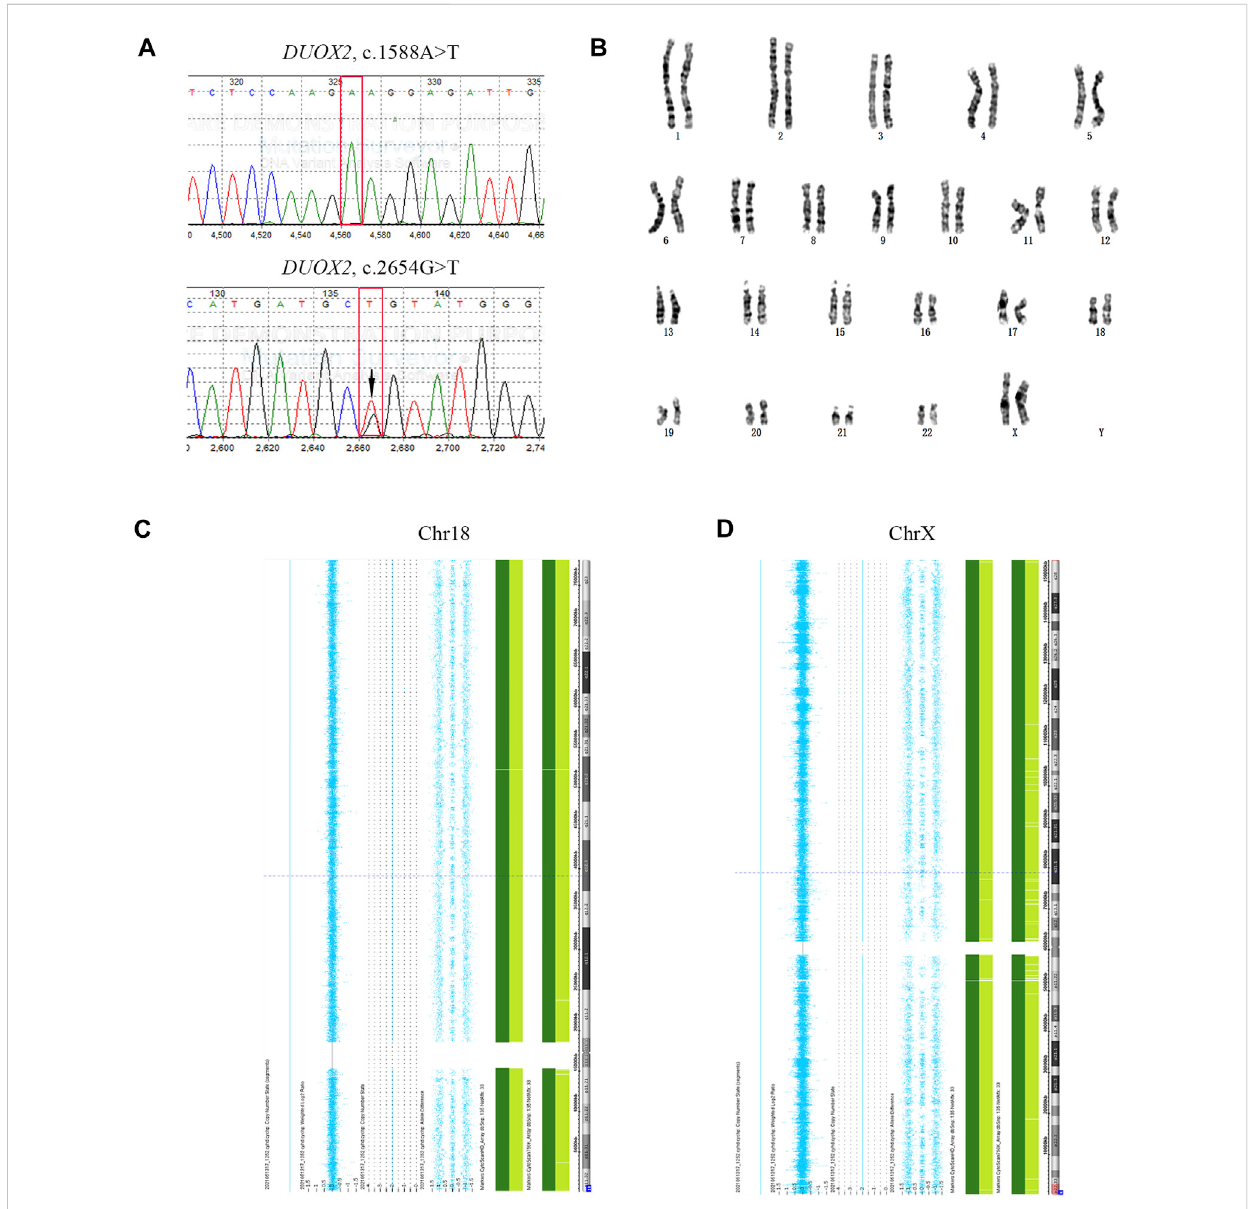
FIGURE 4 Prenatal diagnostic results. (A) Sanger sequencing results for fetal DUOX2 mutations. Red boxes represent targeted mutation sites. The arrow indicatesthe DUOX2 ,c.2654G > T(p.R885L)mutation. (B) Amniotic fl uidkaryotypingofthefetus,revealinganormalkaryotype. (C,D) ResultsofSNParray- based comprehensive chromosome